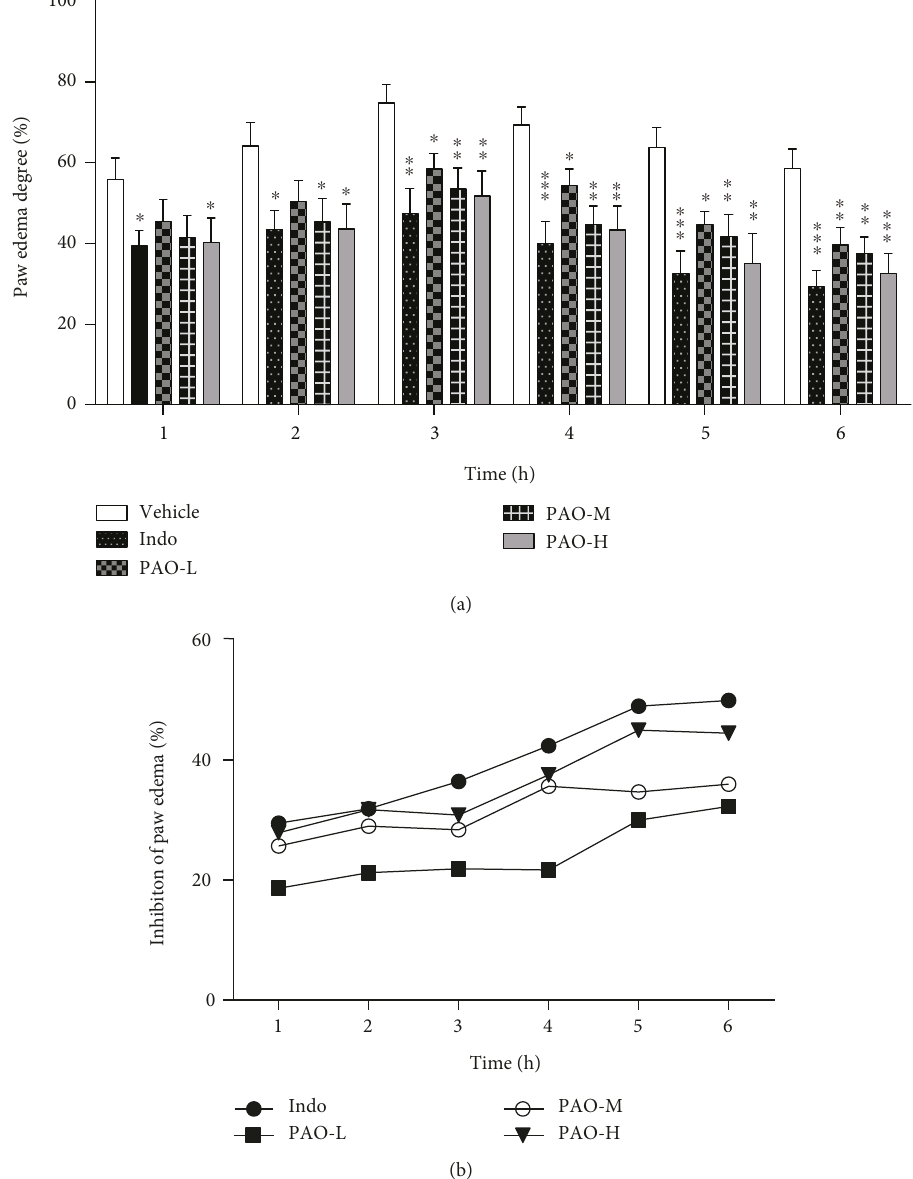
Figure 5: Anti-in fl ammatory e ff ect of PAO on carrageenan-induced paw edema in mice. Indo: indomethacin (10 mg/kg); PAO-L: low dose of PAO (10 mg/kg); PAO-M: medium dose of PAO (20 mg/kg); PAO-H: high dose of PAO (40 mg/kg). (a) Paw edema degree was represented as the ratio of the paw volume variation between basal volume (0h) and di ff erent time interval (1, 2, 3, 4, 5, and 6h) volumes after carrageenan treatment. (b) Inhibition of paw edema (%) was represented as the paw volume di ff erence between the vehicle group and the administration groups. Data were expressed as means ± SEM. ( n = 10 ), ∗ p < 0 05 , ∗∗ p < 0 01 , and ∗∗∗ p < 0 001 versus the vehicle